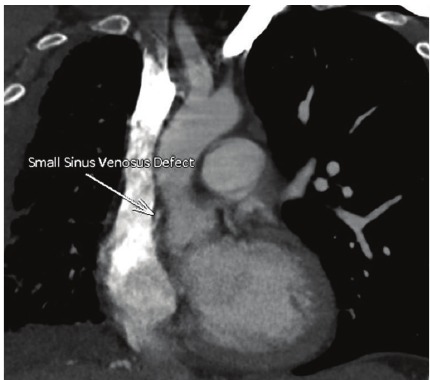
Figure 4: Coronal plane showing sinus venosus collateralization betweenthehypertrophiedsystemicvesselsandthediminutiveright pulmonary